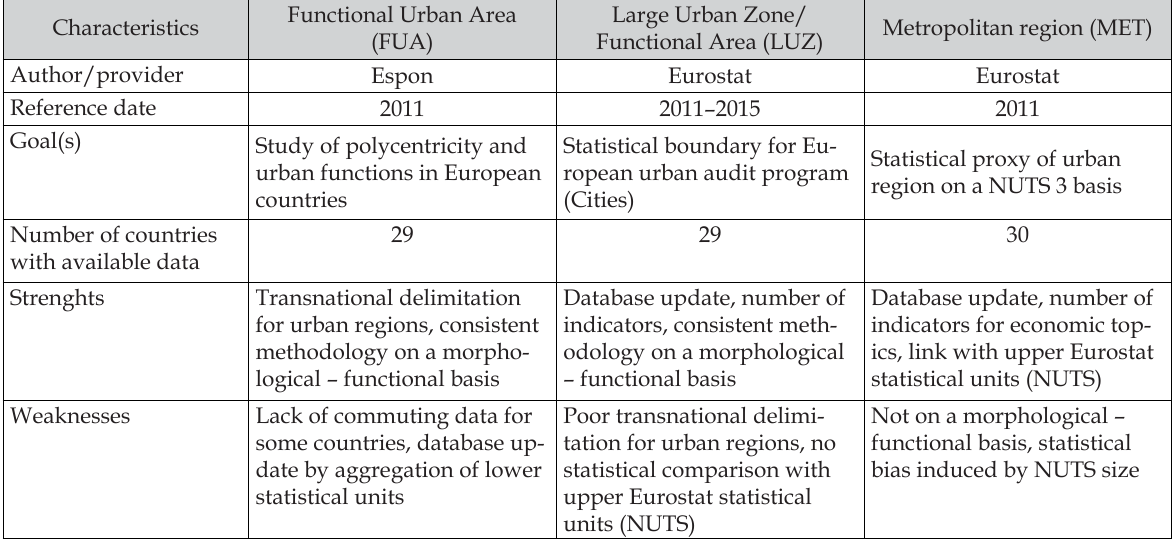
Table 2. Main characteristics of urban databases at the European